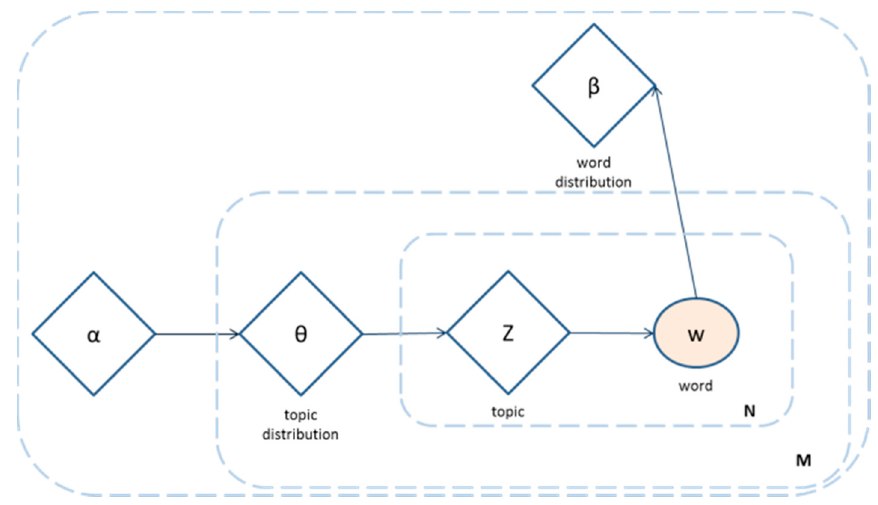
Figure 5. Latent dirichlet allocation (LDA) graphical model according to [63], α and β are corpus-level parameters, θ are document-level variables, and z and w are word-level variables.